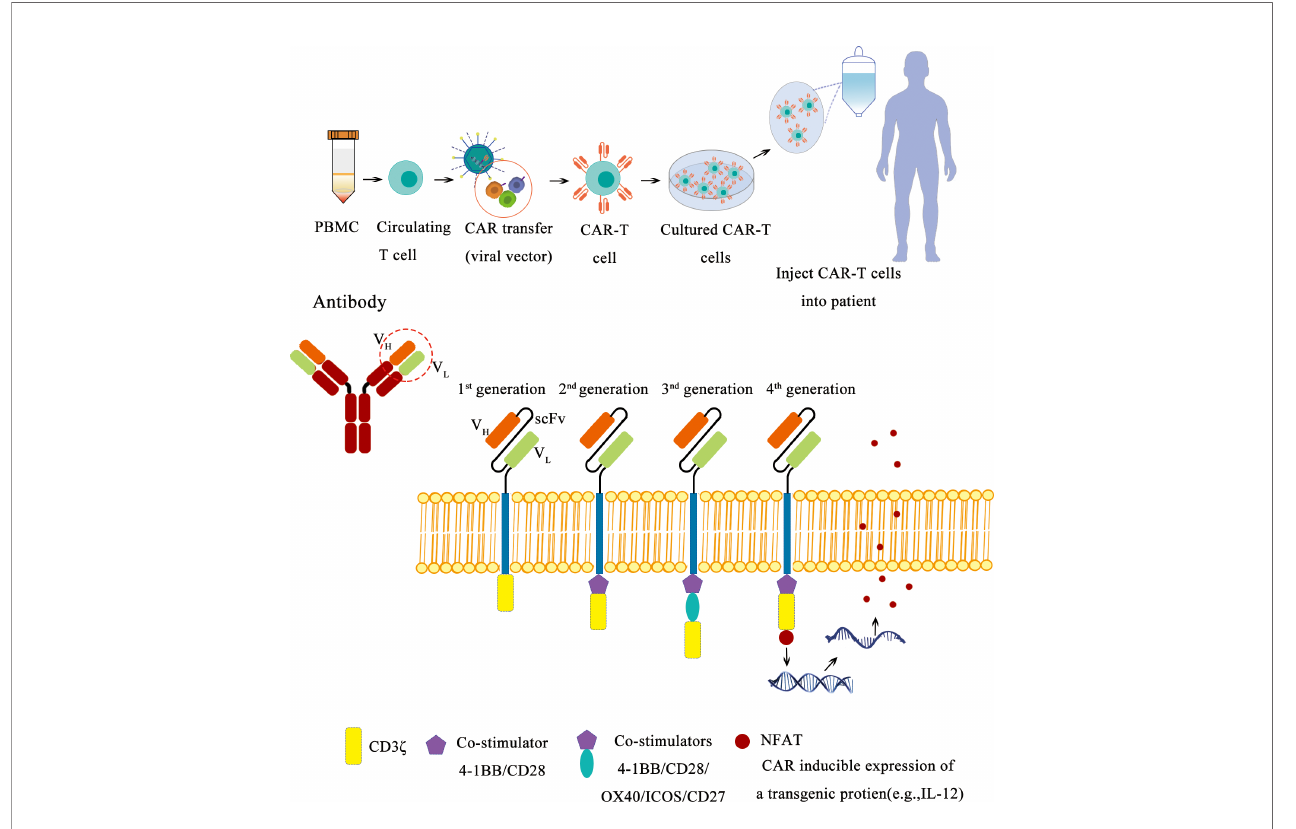
FIGURE 4 | Schematic diagram of CAR-T